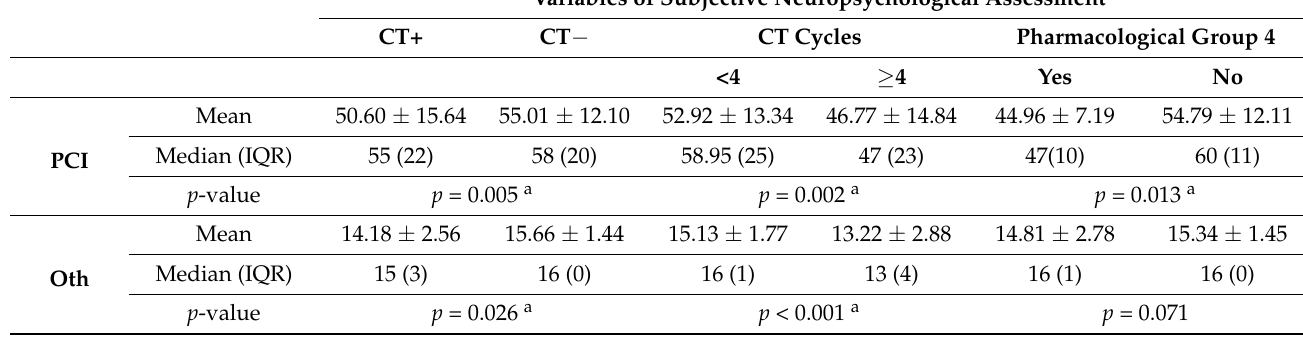
Table 4. Relationships between CT (+, − ) groups, subjective neuropsychological assessment variables, and therapeutic